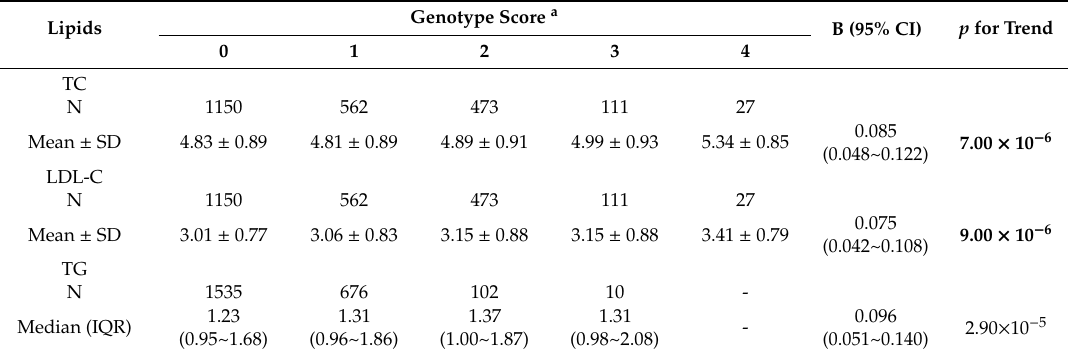
Table 4. Cumulative e ff ects of the risk alleles on TC, LDL-C, and TG.